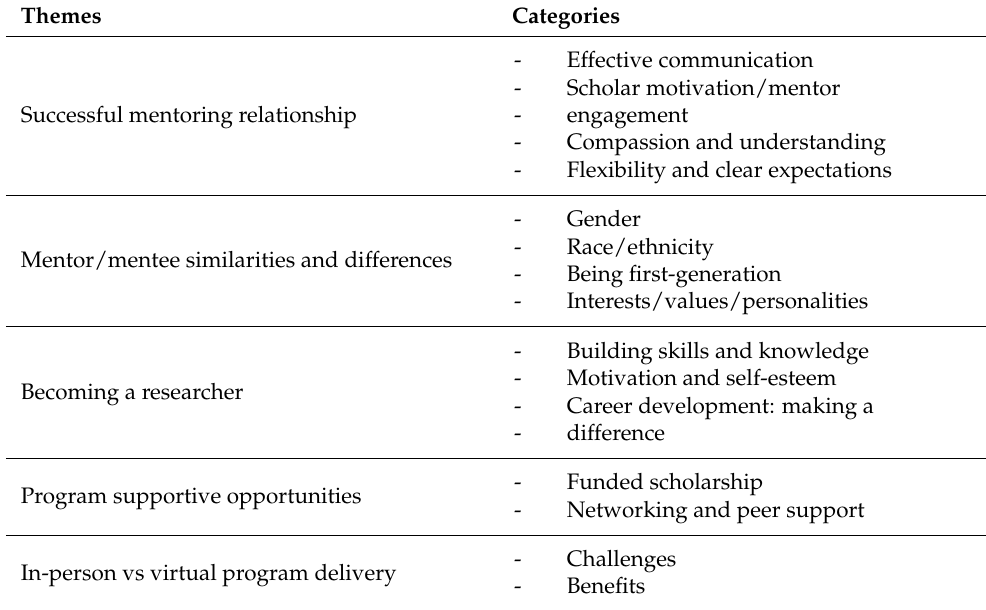
Table 3. Themes and categories identified in data analysis of the transcripts of interviews with mentees and